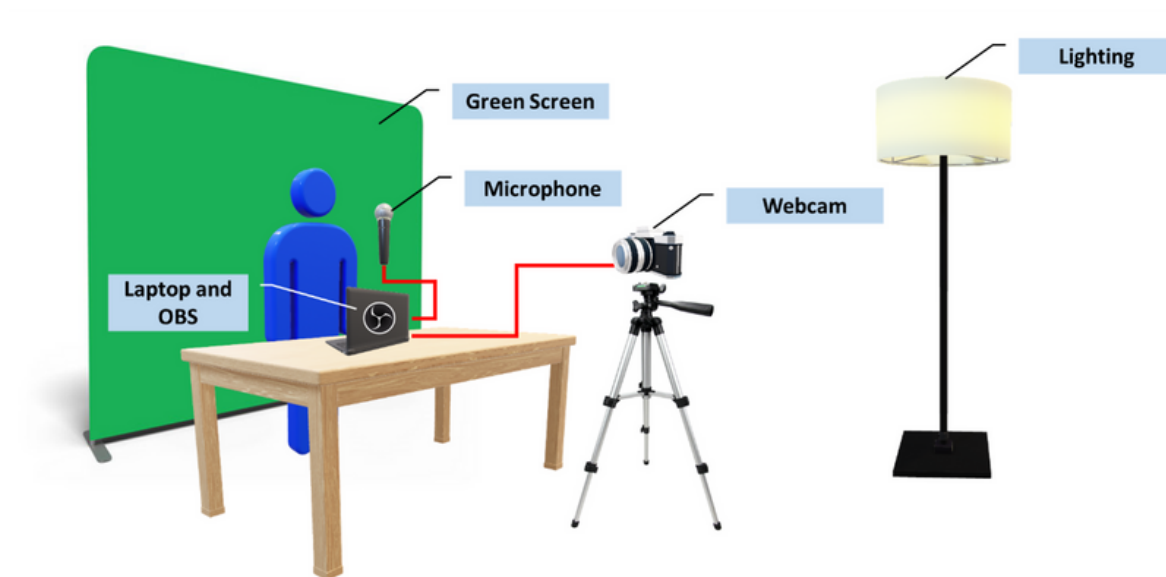
Figure 10. Minimally sufficient home studio setup for online teaching, which includes six components: laptop, OBS software, microphone, webcam, green screen, and a good source of